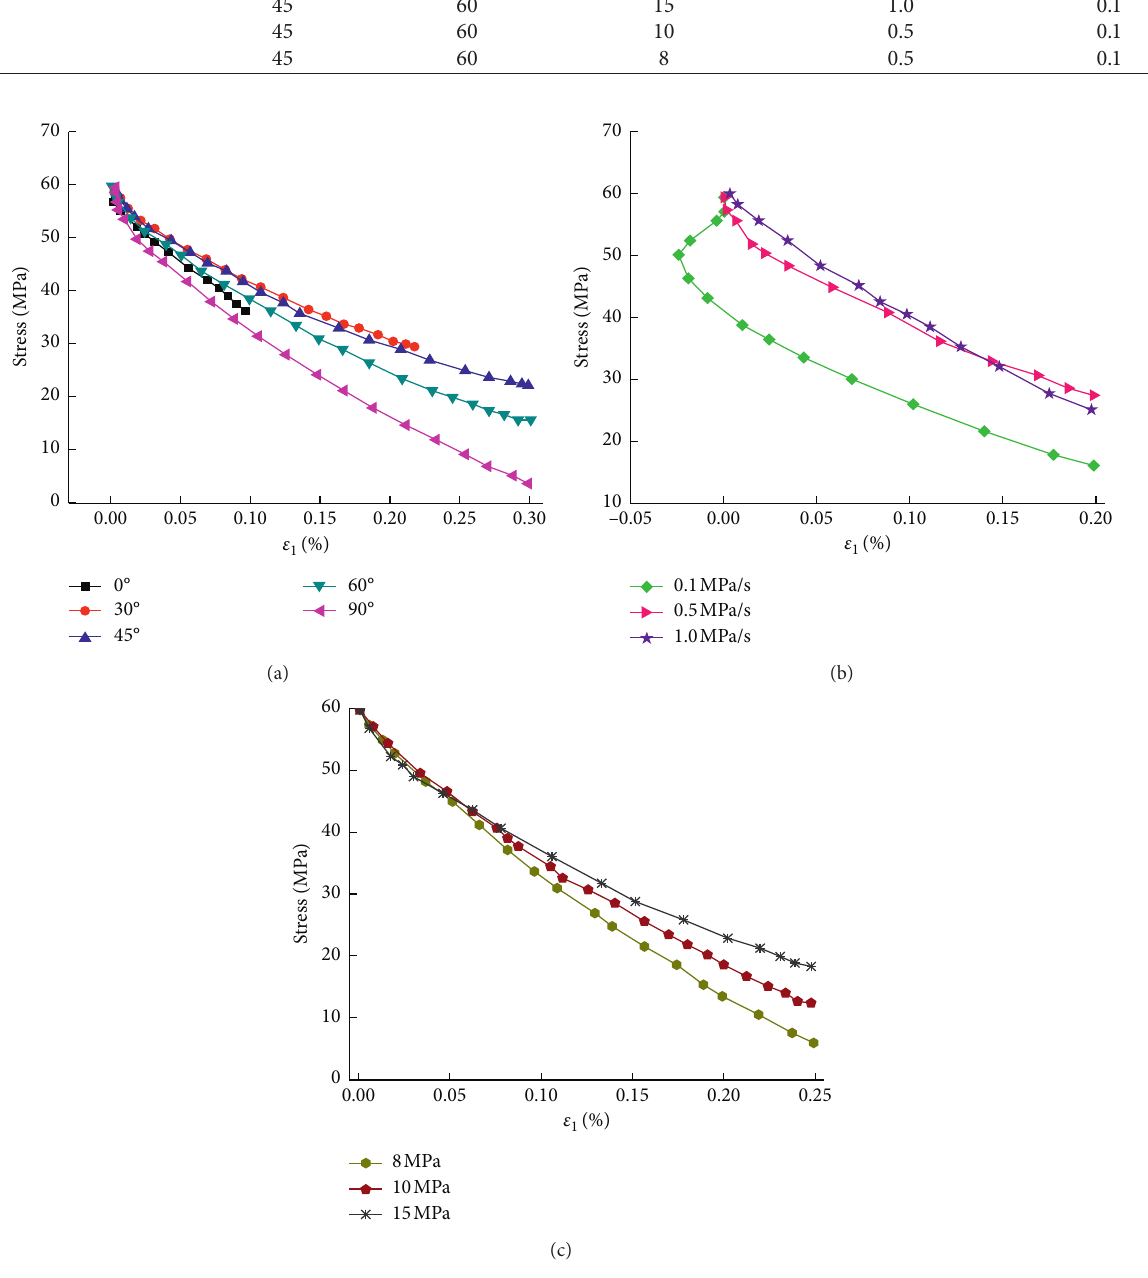
Figure 3: ( σ − σ ) − ε curves of cracked specimens under axial unloading and radial unloading conditions. (a) Effect of crack angle. (b) 1 3 1 Effect of unloading rate of confining pressure. (c) Effect of initial confining